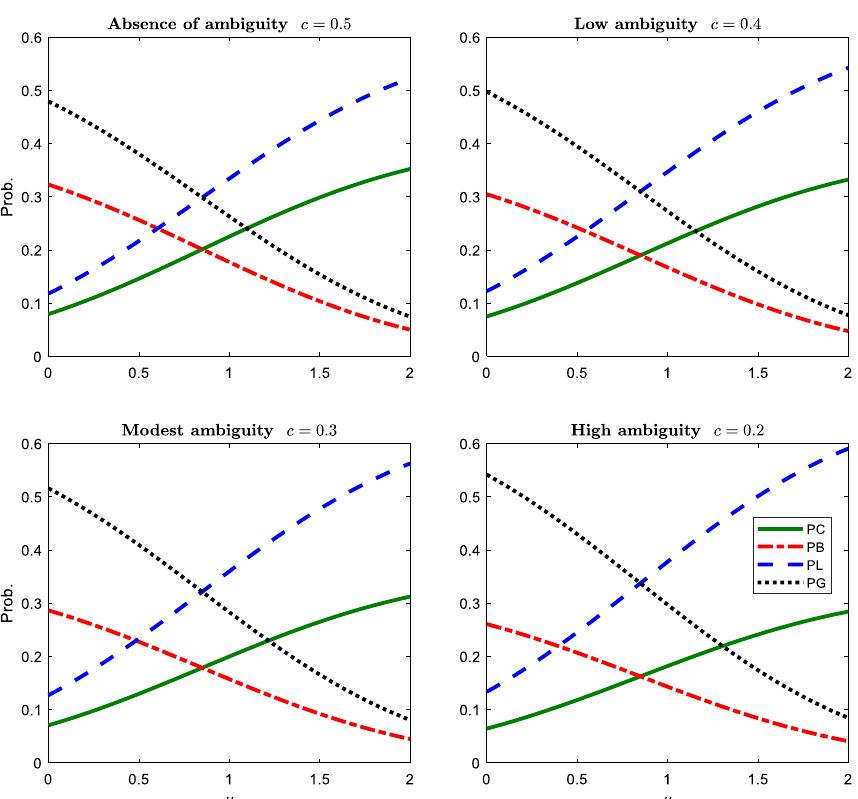
Fig. 3 Probabilities of the four strategies under ambiguity when the profitability of the future innovation, µ , varies. PC , PB , PL , and PG represent the probabilities of pursuing compulsive, buy‑and‑hold, leapfrog, and laggard strategies, respectively. Parameter c represents the degree of ambiguity perceived by managers. When c = 0.5 , ambiguity is absent, implying that managers are neutral toward ambiguity. The upper left figure illustrates Fig. 2 in Grenadier and Weiss (1997). As c decreases, the degree of ambiguity increases. Here, c = 0.2 represents the highest degree of ambiguity perceived by managers. As the profitability of